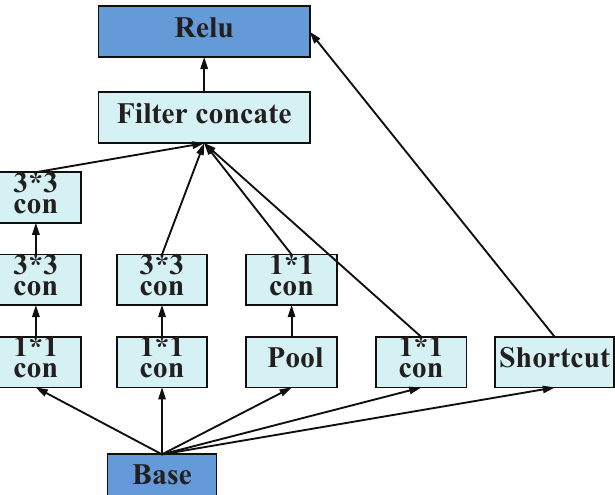
Figure 5. Multi-branch convolution module (MBC-module). By replacing the large convolution kernel with a smaller size convolution kernel, not only can the parameters be reduced, but also the nonlinear ability of the model can be improved.